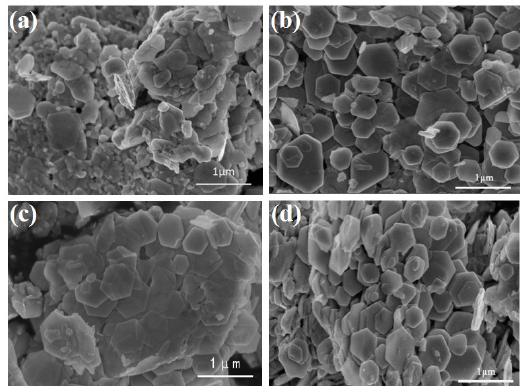
Fig. 2 SEM images of the nanopowders: (a) Lu 0.1 Bi 1.9 Te 3 ; (b)